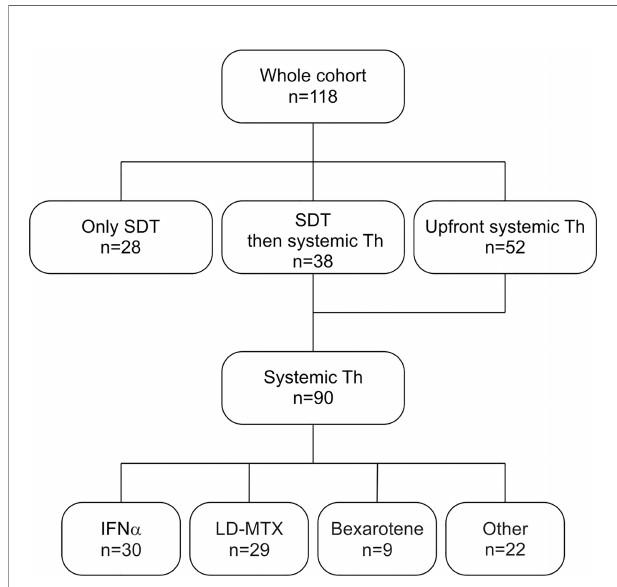
FIGURE 1 | Flowchart of administrated therapies – SDT and 1 st line systemic therapy. Other systemic agents include IFN a +LD-MTX, chlorambucil, single- agent- and polychemotherapy, systemic corticosteroids and hydroxyurea. SDT – skin directed therapy. Th – therapy. IFN a - interferon alpha. LD-MTX- low-dose